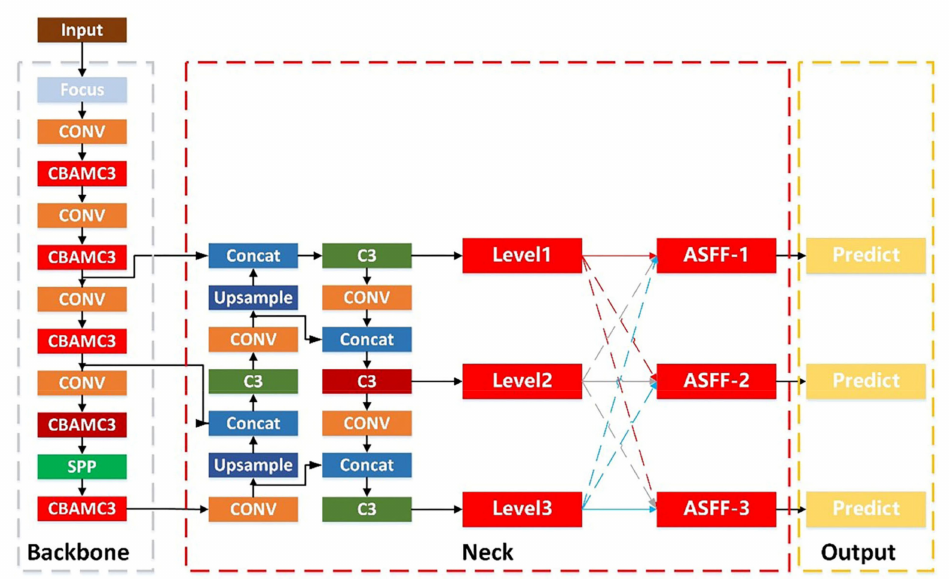
Figure 2. Structure of improved YOLOv5